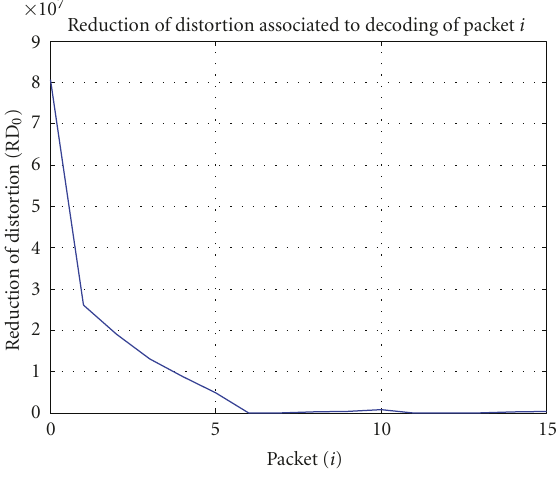
Figure 11: Reduction of distortion of JPEG 2000